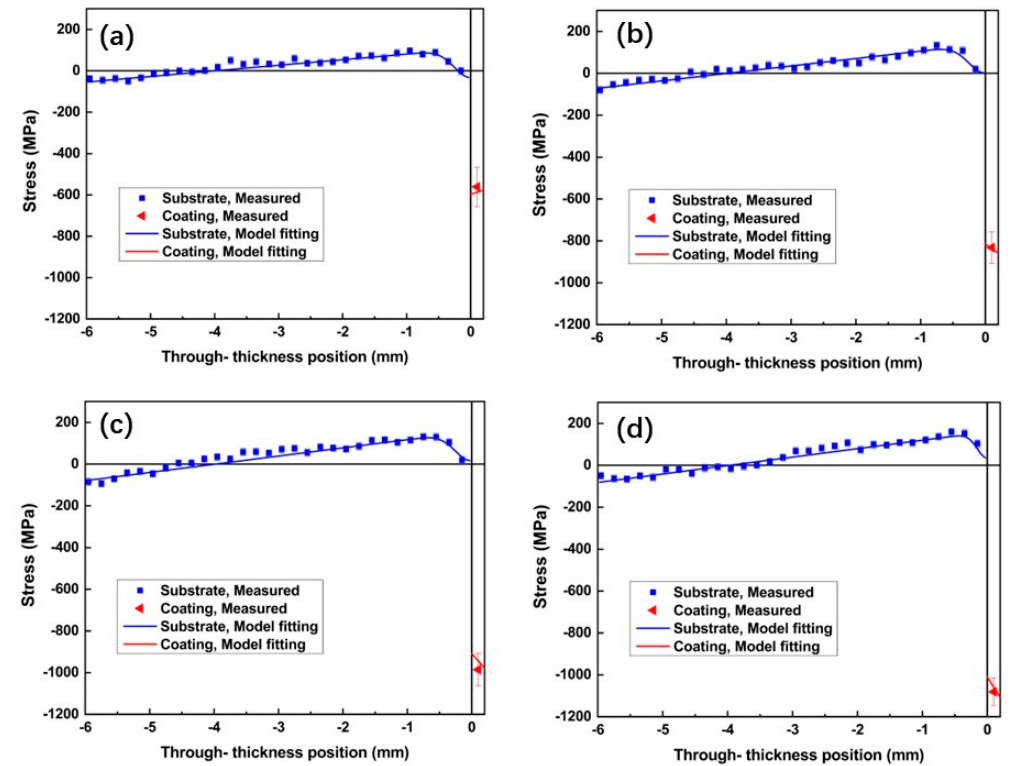
Figure 12. Stress distributions in the four WC–10Co–4Cr coating/steel substrate samples. Symbols with error bars represent experimental data, while lines correspond to an empirical model fitting the data sets. ( a ) N; ( b ) B1; ( c ) M; ( d ) B2.